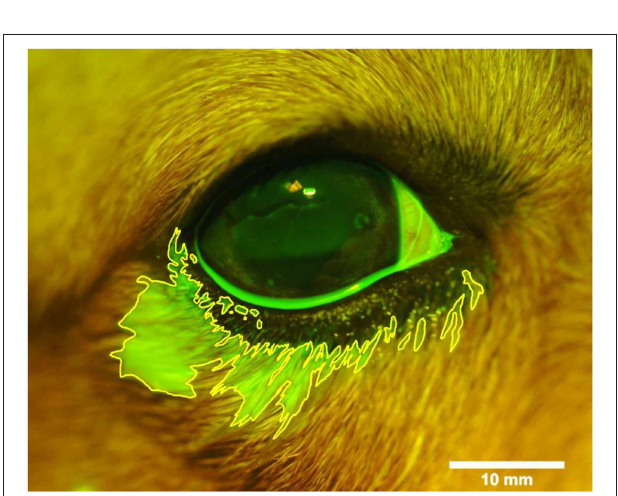
FIGURE 2 | Photograph of the right eye and eyelids following topical instillation of 90 µ l of 0.1% fluorescein in a representative Beagle dog. The area of periocular spillage was delineated with ImageJ software (version 1.52a, National Institute of Health), and recorded in mm 2 based on a length bar (10mm) specific to each eye.